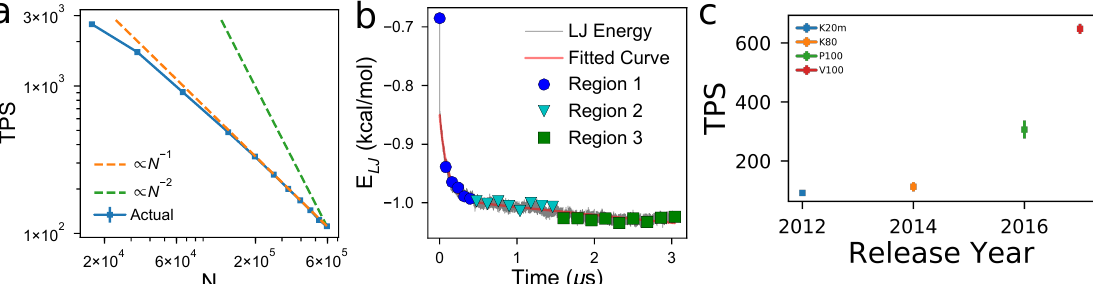
Figure 2. GPU-accelerated simulations of P3HT presented here achieve ideal performance scaling, but practical equilibration of a volume is limited by relaxation times. ( a ) computational performance measured by Timesteps Per Second (TPS, blue data) scales O ( N − 1 ) (dashed orange line for simulations performed at T = 600 K at ρ = 0.72 g/cm 3 and ε s = 0.8); ( b ) the time evolution of non-bonded potential energy shows a fast initial structural rearrangement (blue), a slower relaxation to equilibrium (cyan), followed by sampling of equilibrium microstates (green). The divergence of relaxation time (cyan) with system size, N , and density, ρ , puts practical limitations on the systems that can be equilibrated, despite high TPS values. ( c ) Computational performance, measured by TPS, has roughly doubled with each new hardware release for the last four generations of Nvidia hardware (K20m, K80, P100, and V100 cards). Error bars indicate one standard deviation over five independent simulations per cluster across multiple